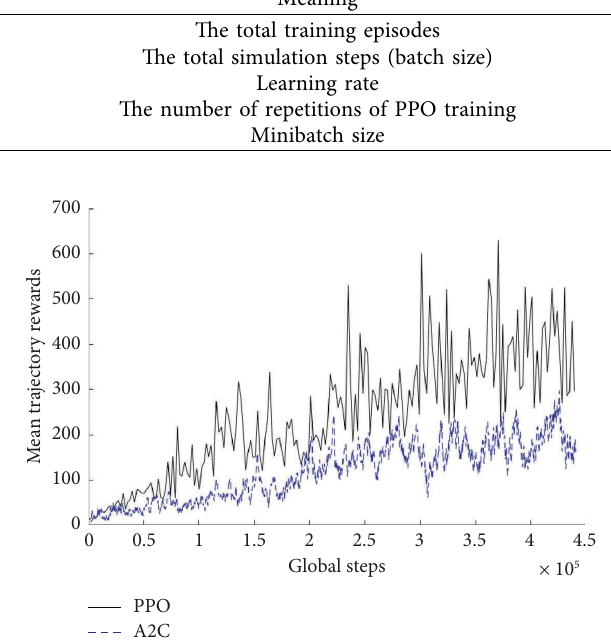
Figure 4: Te change of the mean trajectory